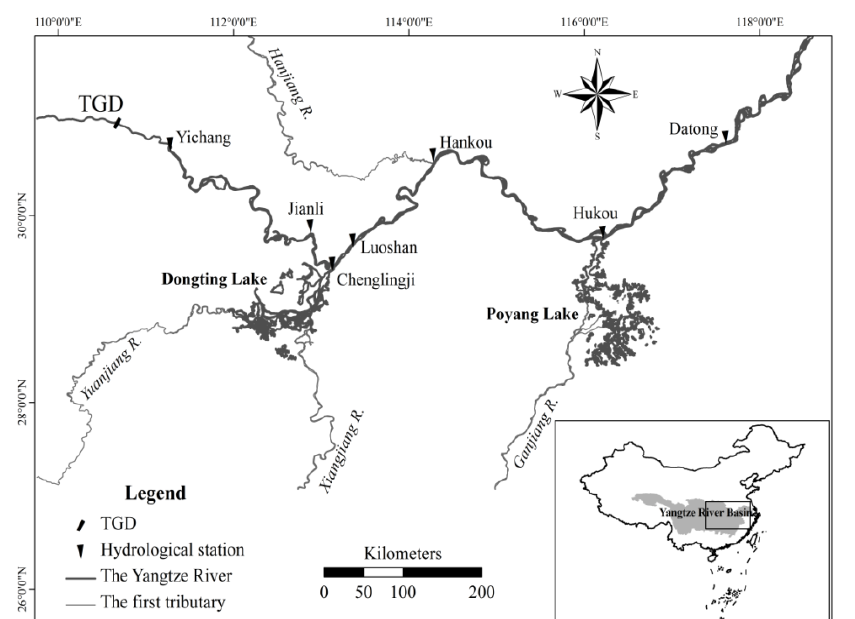
Figure 1. Location of the study region and the hydrological